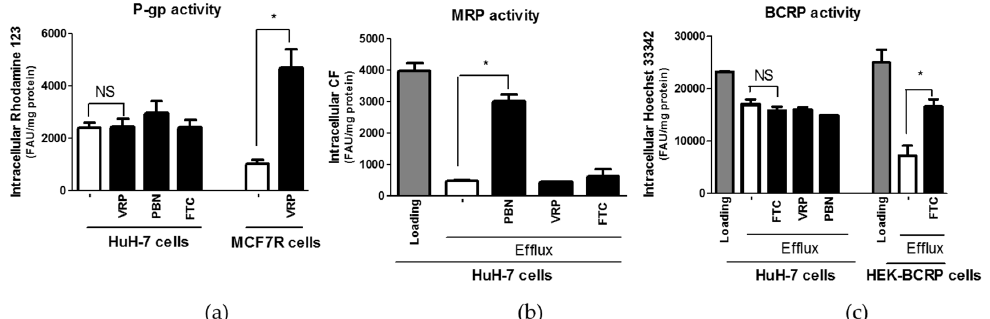
Figure 4. Activities of the canalicular ABC efflux transporters P-glycoprotein (P-gp) ( a ), multidrug resistance-associated proteins (MRPs) ( b ) and breast cancer resistance protein (BCRP) ( c ) in HuH-7 cells. For P-gp activity, HuH-7 were incubated for 30 min with the P-gp substrate rhodamine 123 in the absence or presence of the ABC transporter modulators verapamil (VPM) (50 μ M), probenecid (PBN) (2 mM) or fumitremorgin C (FTC) (10 μ M); MCF7R cells were used in parallel as control P-gp-positive cells. For MRP activity, HuH-7 cells, initially loaded with the MRP substrate carboxy-2,7-dichlorofluorescein (CF) used under its diacetate ester form for 30 min, were reincubated in CF diacetate-free medium cells for 60 min in the absence or presence of ABC transporter modulators. For BCRP activity, HuH-7 cells, loaded with the BCRP substrate Hoechst 33342 for 30 min, were reincubated in Hoechst 33342-free medium for 90 min in the presence or absence of ABC transporter modulators; BCRP-transfected HEK 293 cells were used in parallel as control BCRP-positive cells. Intracellular levels of fluorescent substrates were next determined by spectrofluorimetry. Data, expressed as fluorescence arbitrary unit (FAU)/mg protein, are the means + SEM of three independent assays. * p < 0.05 and NS, not statistically significant (ANOVA followed by Tukey’s post-hoc test or Student’s t -test).